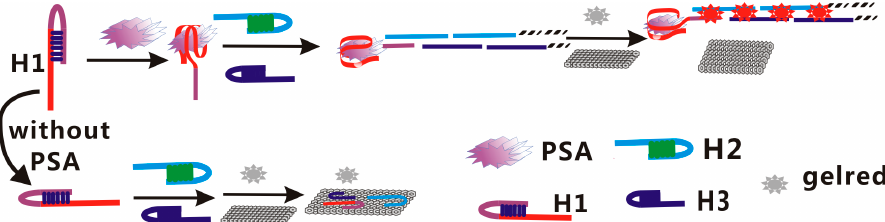
Figure 1. Schematic illustration of the fluoroimmunoassay detection of prostate specific antigen (PSA) based on the combination of target-triggered hybridization chain reaction, GelRed and graphene oxide (GO).